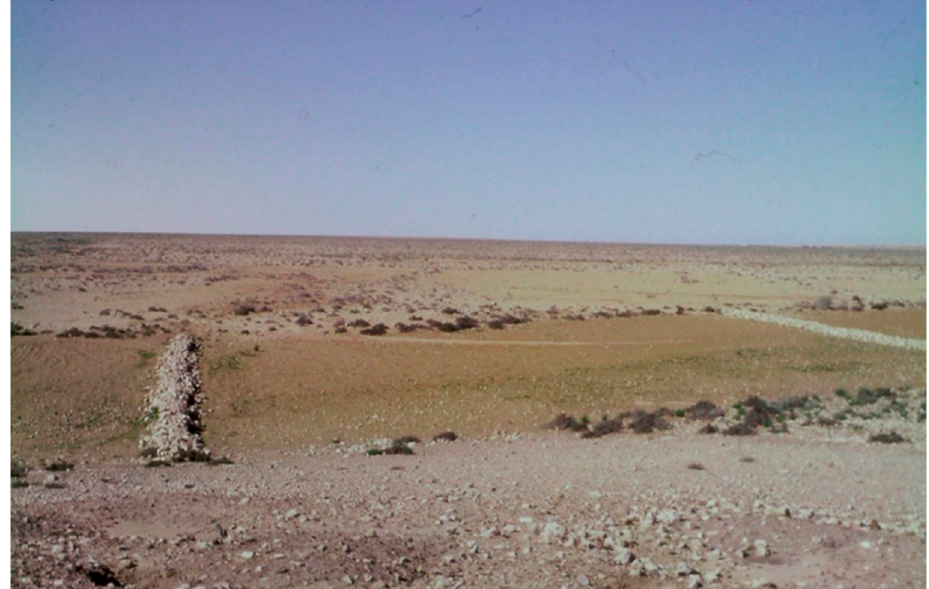
Figure 5. Soil accumulation and agricultural cultivation in the Marmarica Plateau, south of Marsa Matrouh. Note the gentle northward slope of the plateau (from left to right), the fine-grained sediments in the background ,and the arable soil accumulated in the shallow valley, cultivated by terrace farming. (Photograph: Y. Avni).